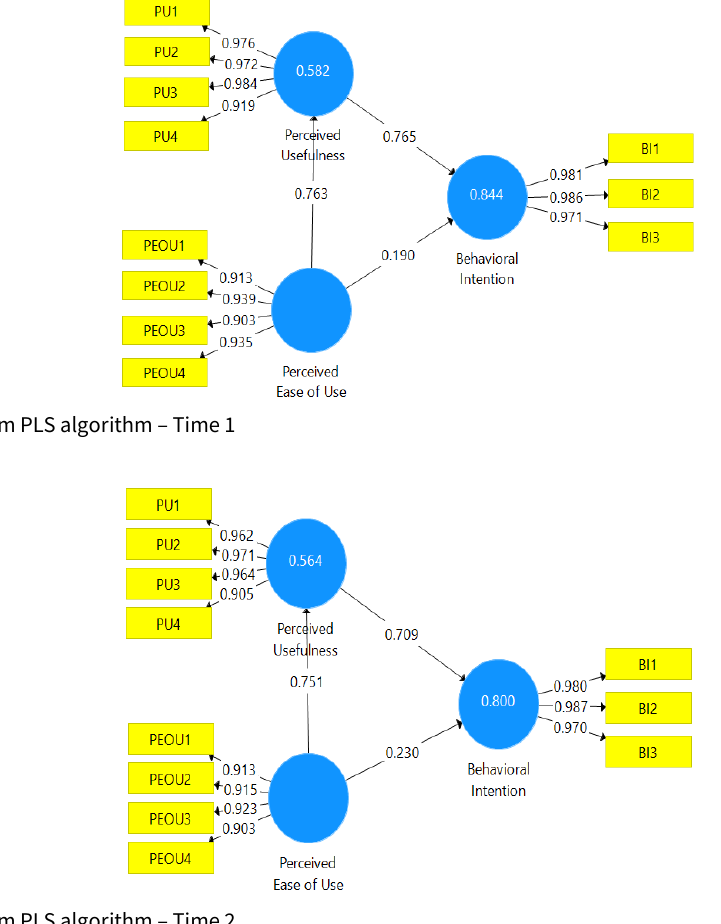
Figure 4. Results from PLS algorithm – Time 2